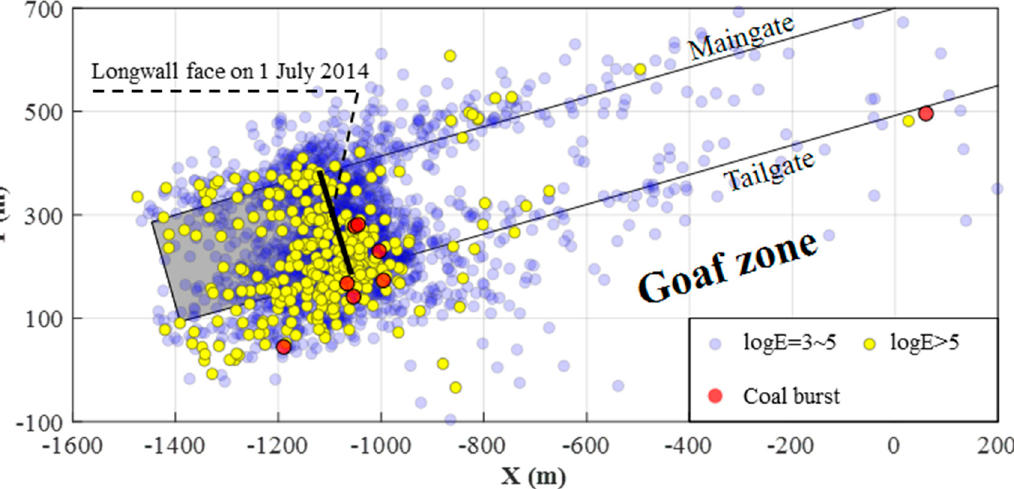
Figure 3. Distribution of coal bursts and seismic events with different energies in LW250105 from 5 April to 1 July 2014. The shaded zone denotes the active goaf behind the longwall face on 1 July 2014.